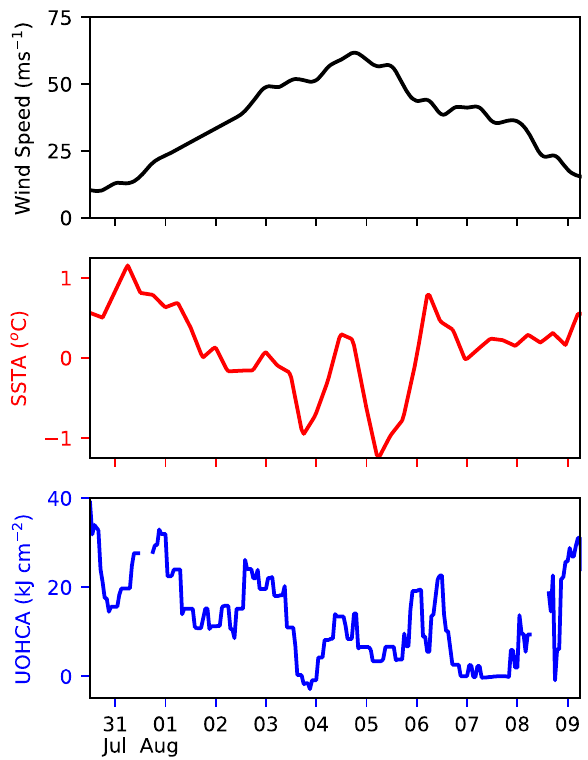
Figure 6. Along-track time series record for Hurricane Iselle through ( Top ) maximum sustained wind speed with TC intensity category indicated, ( Center ) SST anomaly, and ( Bottom ) UOHC anomaly. Landfall is denoted by a break in the UOHC anomaly record. Gap in UOHC anomaly coverage occurred during landfall event.